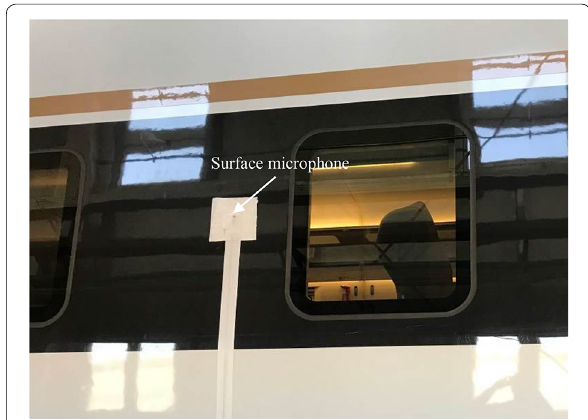
Figure 28 Photograph of the surface microphone installed on the sidewall outside